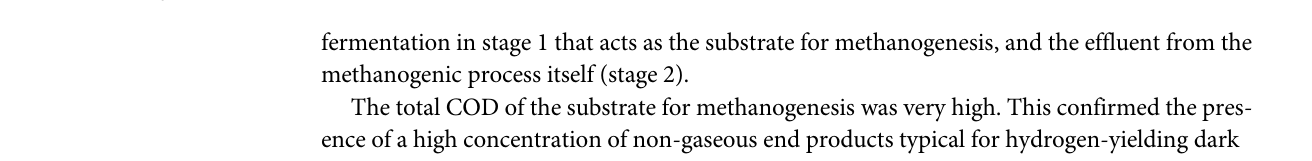
Fig 1. Rarefaction curve obtained from MEGAN5 classification. The curve does not flatten within our sequencing depth, but the increase in the number of leaves in taxonomy is small (ca. 150 leaves with minimal support of 50 per 100,000 reads).